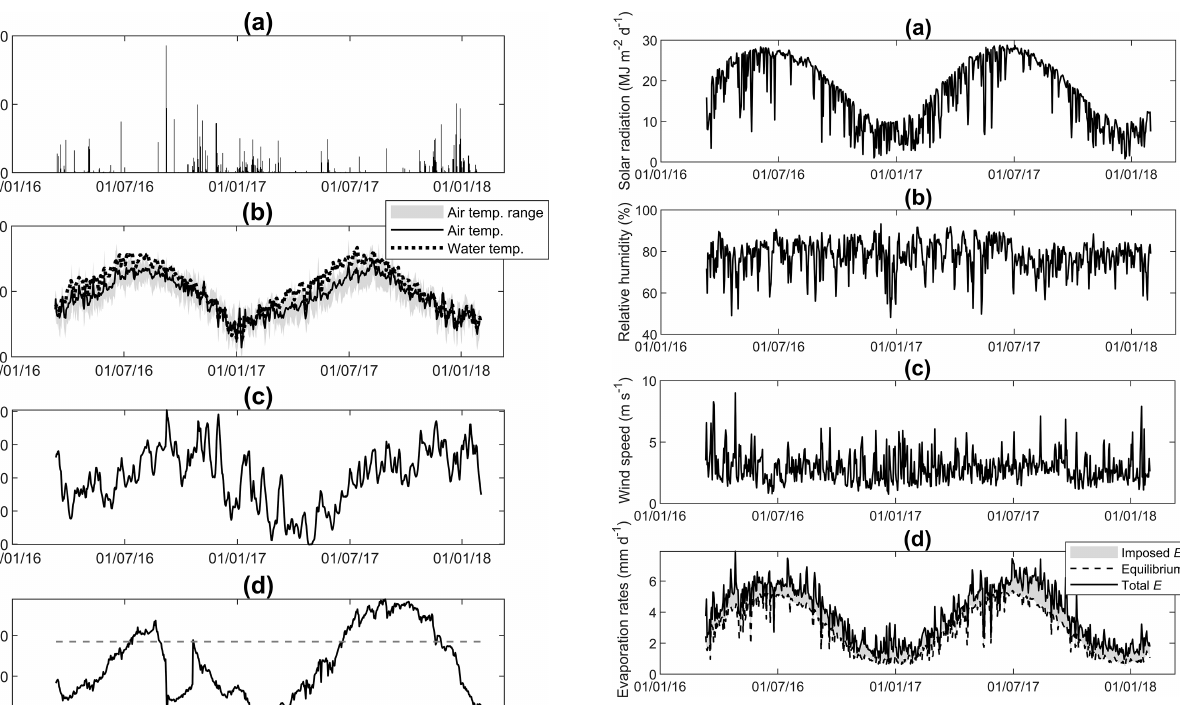
Figure 3. Time series of (a) daily total incoming shortwave radia- tion, (b) daily mean relative humidity, (c) wind speed, and (d) cal- culated evaporation rates (Eq. 7), further decomposed into equilib- rium evaporation (dashed black curve) and “imposed E ”; i.e., the aerodynamic component of evaporation (shaded